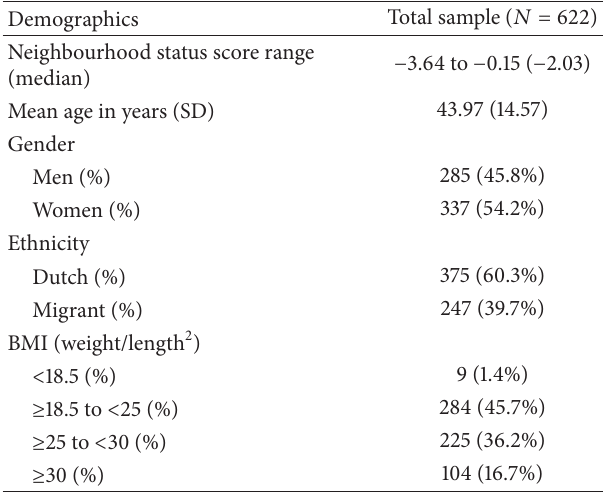
Table 1: Population